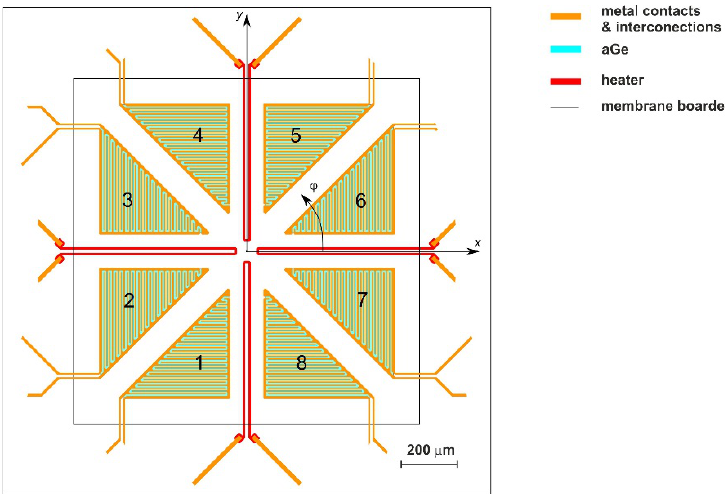
Figure 7. Best performing membrane design comprising eight triangular thermistors arranged side by side with four slim heating resistors on a square membrane. The four linear heaters are connected in parallel or in series to ensure a fourfold rotational symmetry of power dissipation in the membrane. The large thermistor areas are beneficial for uniform transduction of flow magnitude and flow direction. Thermistor numbering refers to the characteristics of Figure 8.